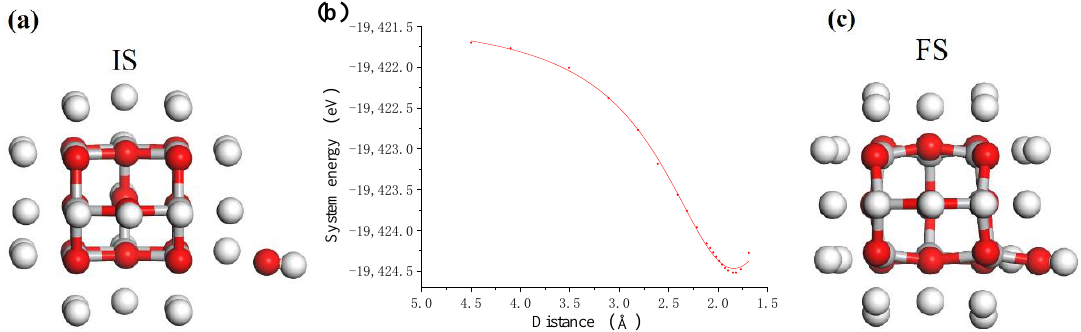
Figure 3. The process of OH group adsorbing on TiO 2 cluster. ( a ) Initial state (IS); ( b ) system energy; ( c ) final state (FS) where white, red and grey balls are hydrogen, oxygen and titanium atoms, respectively.